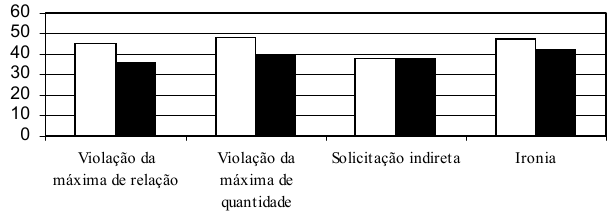
Figura 1. Tempo de leitura nas diferentes categorias de atos de fala, quando o texto era implícito e